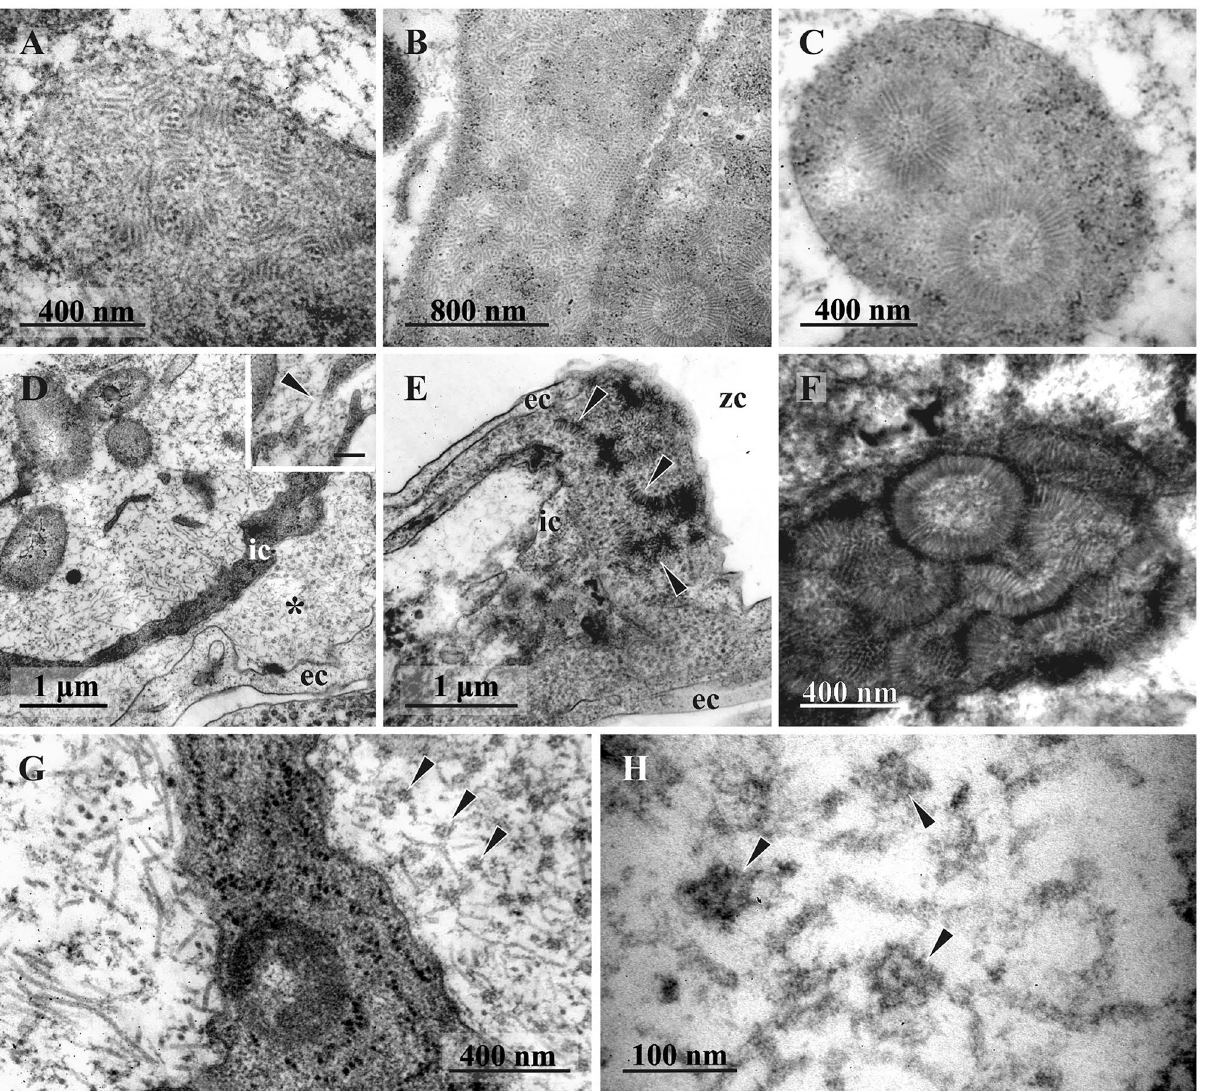
Figure 9. Stages of formation of putative virus-like particles in funicular bodies at late-advanced stages of degradation (collected on 23 August 2021 and 31 September 2019) (TEM). ( A – C ) VLP and ‘self-constructed’ spherical complexes inside bacteria (23 August 2021); ( D ) VLP in symbiont-containing cavity near bacteria and in ILS between two FB cell layers (asterisk) (inset: probable perforation of the inner cell layer acting as a passage for VLPs transfer to ILS shown by arrowheads, scale bar 200 nm) (23 August 2021); ( E , F ) Self-assembling/ constructing of spherical complexes (arrows) inside ILS (31 September 2019). ( G ) ‘Globules’ (arrowheads) and ‘fibrils’ inside ILS (to the right), and filaments in FB inner cavity (to the left) divided by inner layer cell; ( H ) ‘globules’ (arrowheads) and ‘fibrils’ inside ILS under higher magnification. ec cells of external layer, ic cells of inner layer, zc zooidal